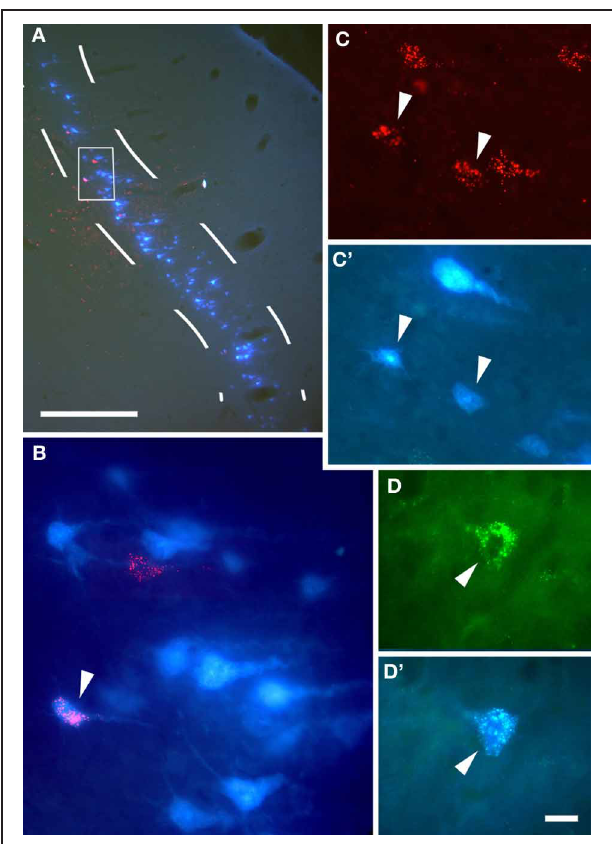
FIGURE 2 | Anatomical tracing experiments in guinea pigs show that cortical cells project to the IC bilaterally. (A) Coronal section at the level of the right auditory cortex showing the overlay of cells labeled retrogradely by injections of Fast Blue in the right IC and rhodamine microbeads in the left IC, with a higher magnification of the area enclosed by the white box in (B) . (C,C’) Double-labeled cortical cells (arrowheads) using the same tracer combination. (D,D’) A double-labeled cortical cell following an injection of Fast Blue in the ipsilateral IC and fluorescein microbeads in the contralateral IC. Arrowheads indicate double labeled cells. Calibration bars: 0.5mm (A) and 20 µ m (B–D) . Modified with permission from Coomes et al. (2005).